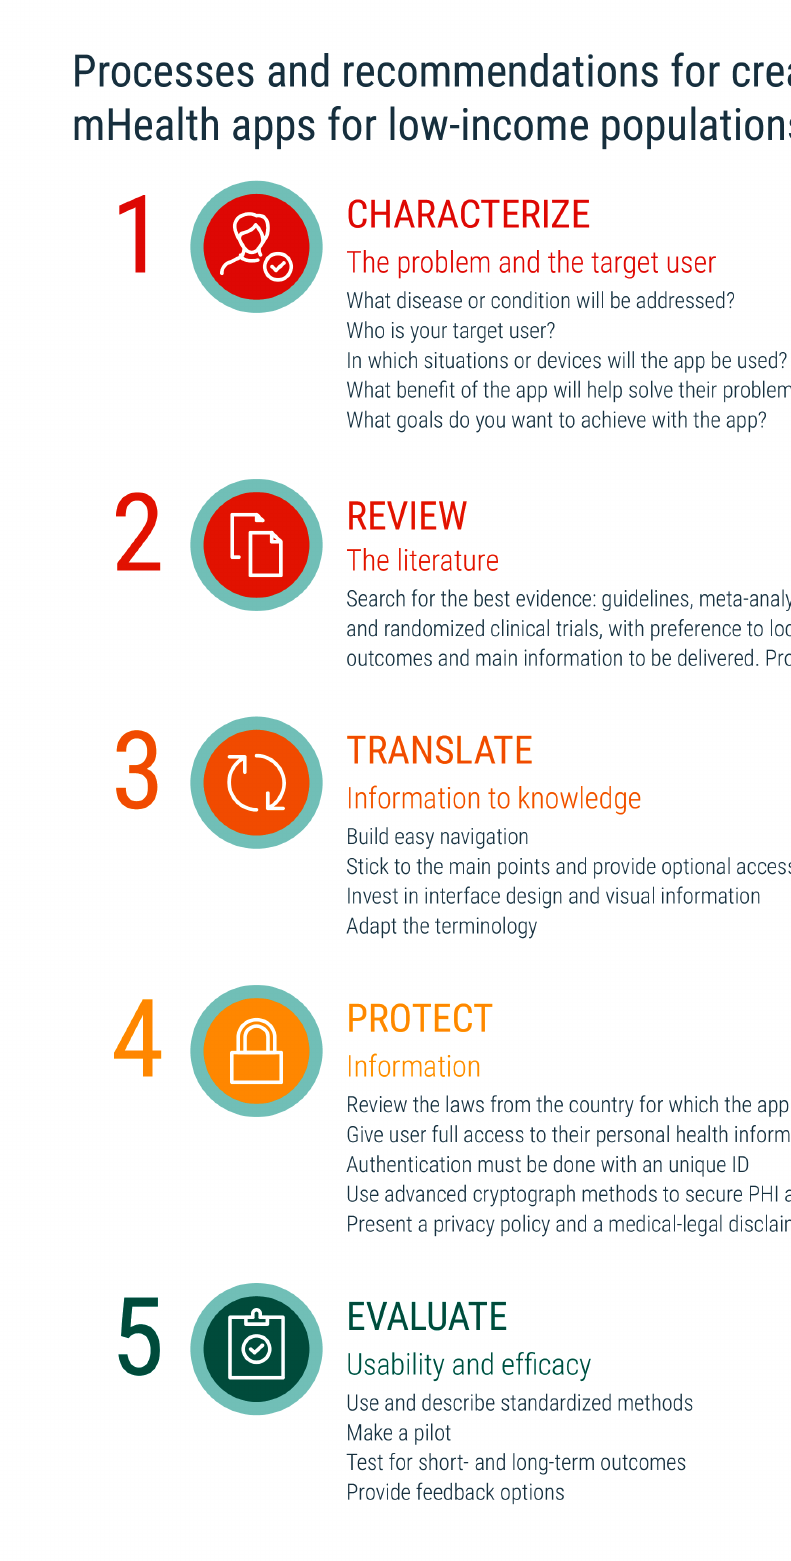
Figure 1. Processes and recommendations for creating mHealth apps for low-income populations, based on the aFib